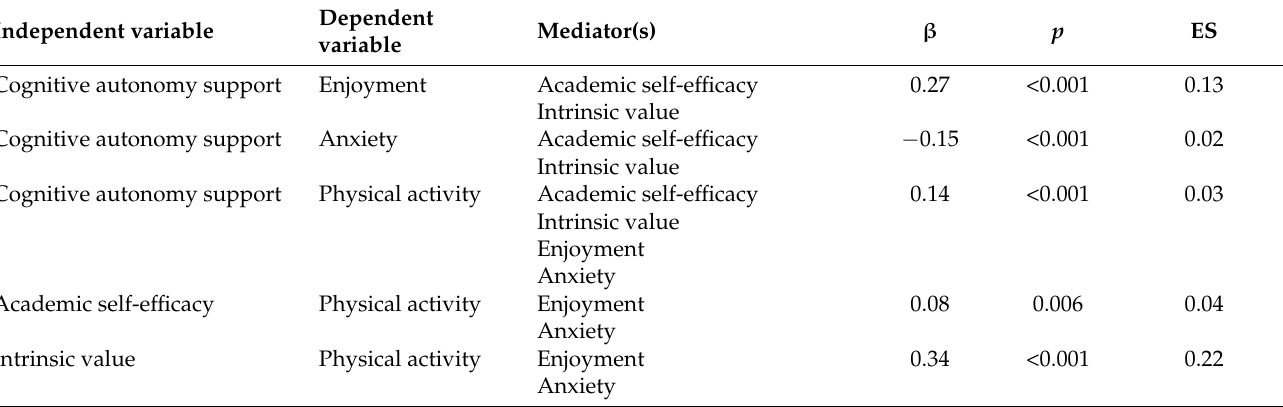
Table 2. Standardized parameter estimates for the indirect effects from the partial least squares analysis. Independent